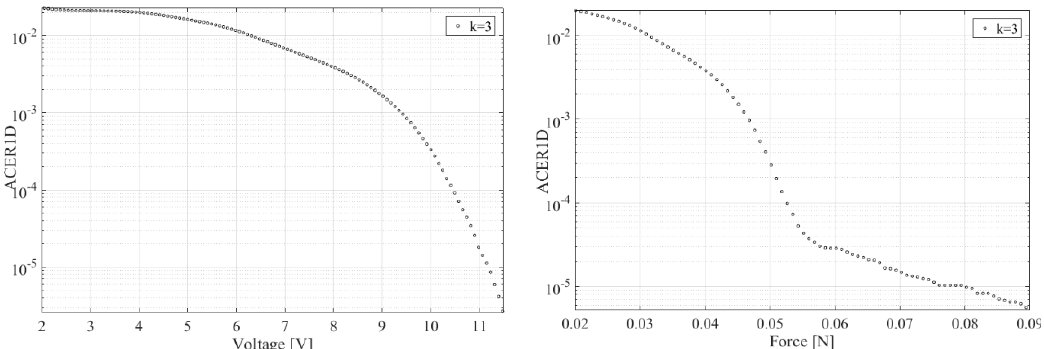
Figure 4. ACER1D marginal statistics voltage versus corresponding force for energy harvester, voltage left, force right. Decimal logarithmic scale on the vertical axis; k is the ACER function conditional parameter.